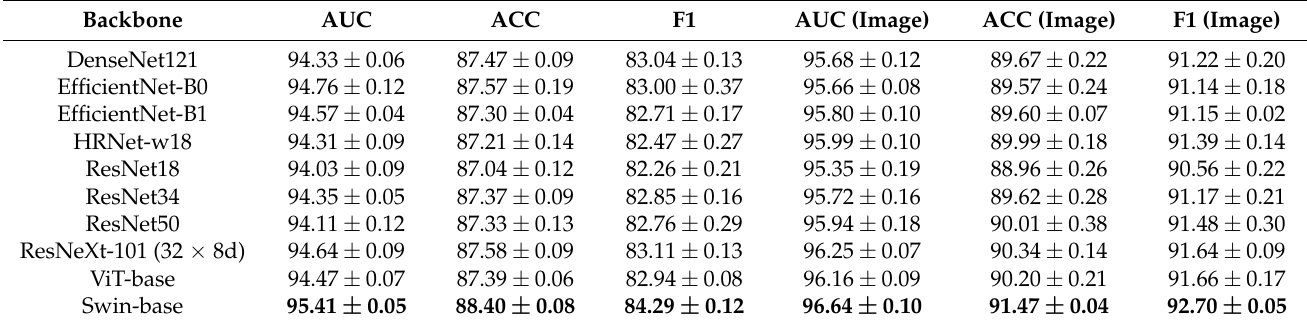
Table 5. Model performance on the BCSS dataset using different